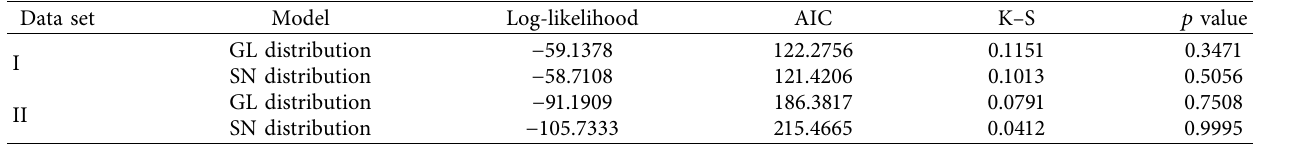
Table 6: The goodness of fit test for SN and GL distributions on the real